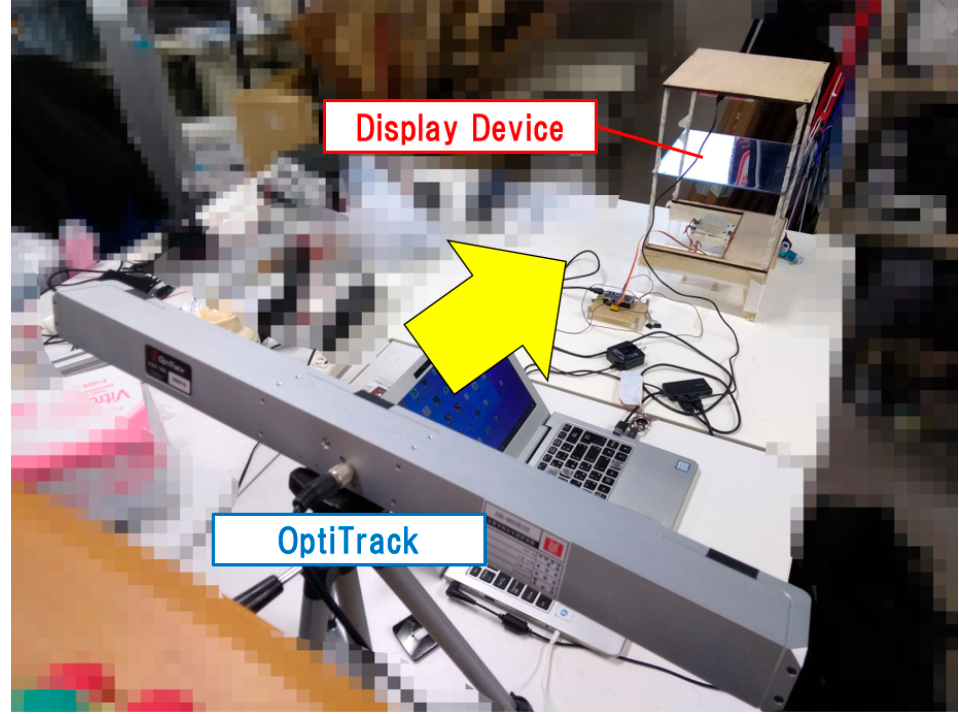
Figure 4. OptiTrack location and display device location.